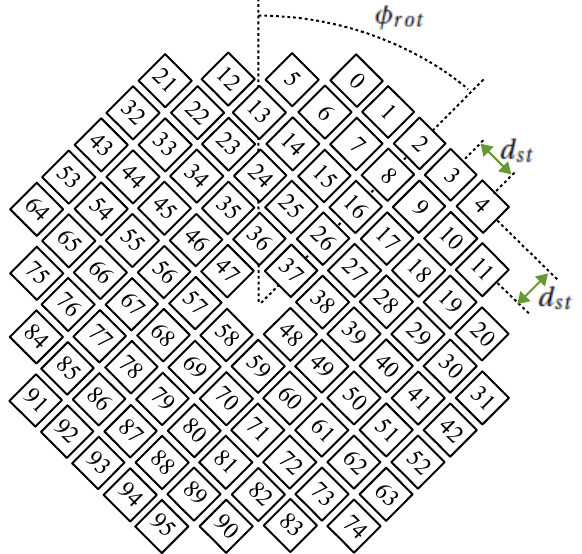
Figure 3. Distribution of LOFAR tiles in the LOFAR station in